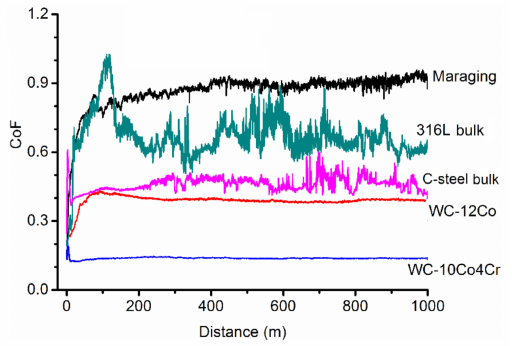
Figure 6. CoF (coefficient of friction) results from ball-on-disk